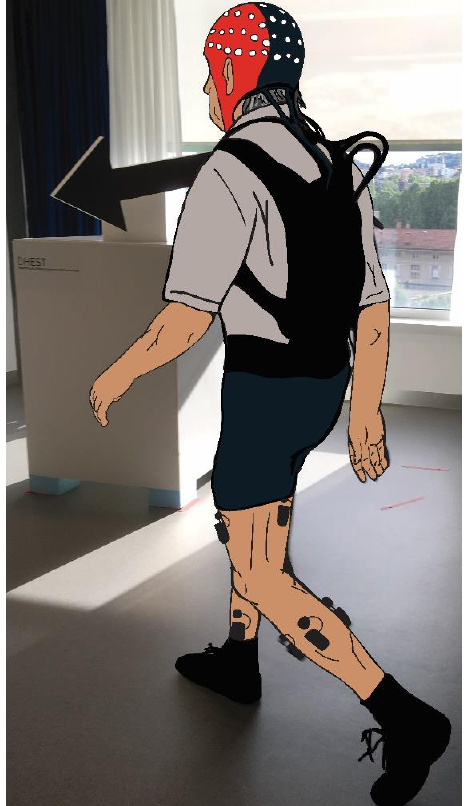
Figure 1. A participant is depicted while approaching to turn around one of the two parallelepiped-shaped structures with an easy-to-spot big black arrow on top showing the turning direction. The figure-8 gait path is composed by two structures as depicted and walking is performed by turning around each structure continuously. The participant walked in the figure-8 gait course, while wearing an EEG cap and EMG sensors over eight muscles of both left and right leg. Moreover, two footswitches were placed under the sole of the foot before wearing socks and shoes. The backpack served to store the amplifier of the EEG cap and additional elements (i.e., cables), however EEG signals were monitored real time remotely.